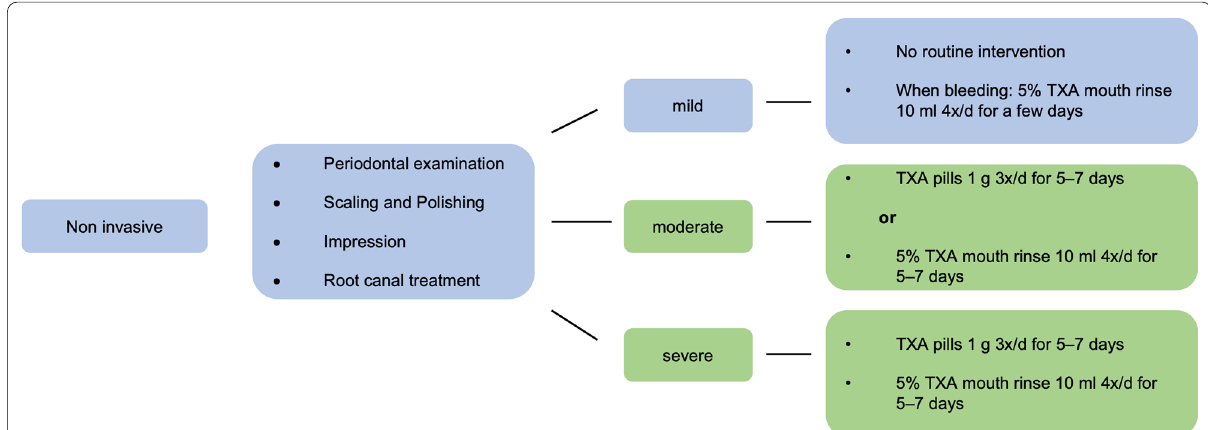
Fig. 1 Exemplary treatment scheme for noninvasive dental treatments. No risk (blue) and low risk (green) (acc. to [2]). TXA: tranexamic acid